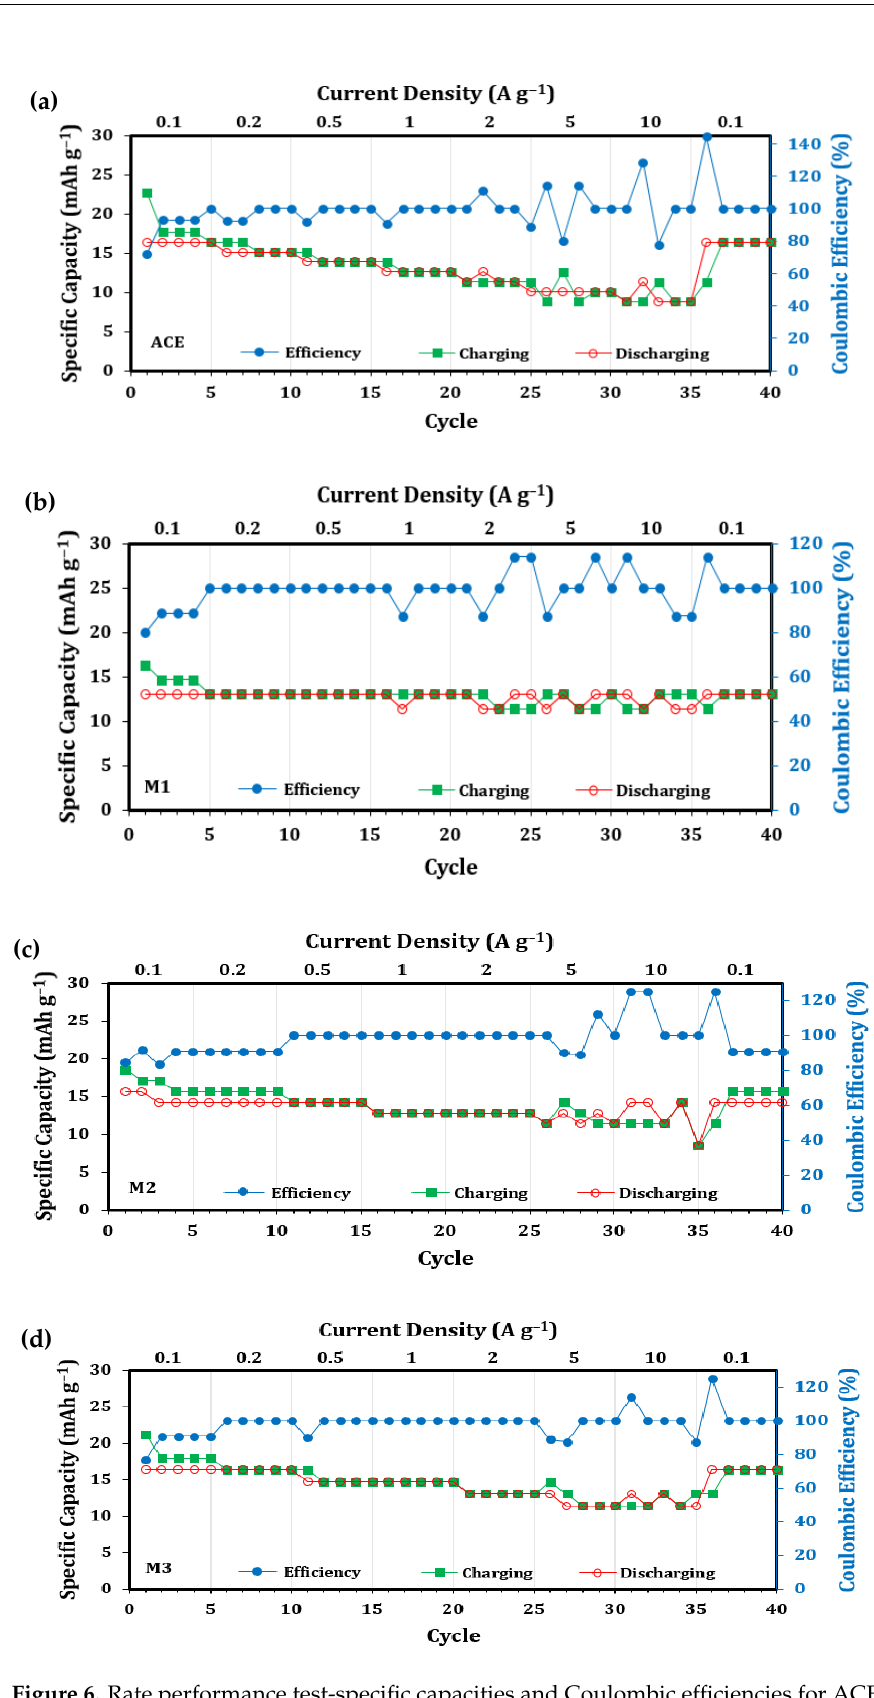
Figure 6. Rate performance test-specific capacities and Coulombic efficiencies for ACE ( a ), M1 ( b ), M2 ( c ), and M3 ( d ).